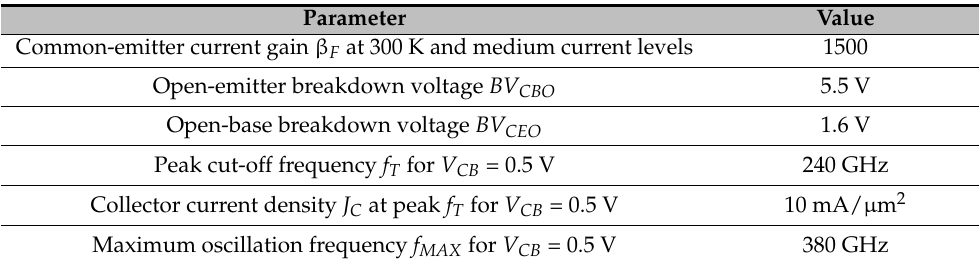
Table 4. Key features of the Si/SiGe NPN HBT under